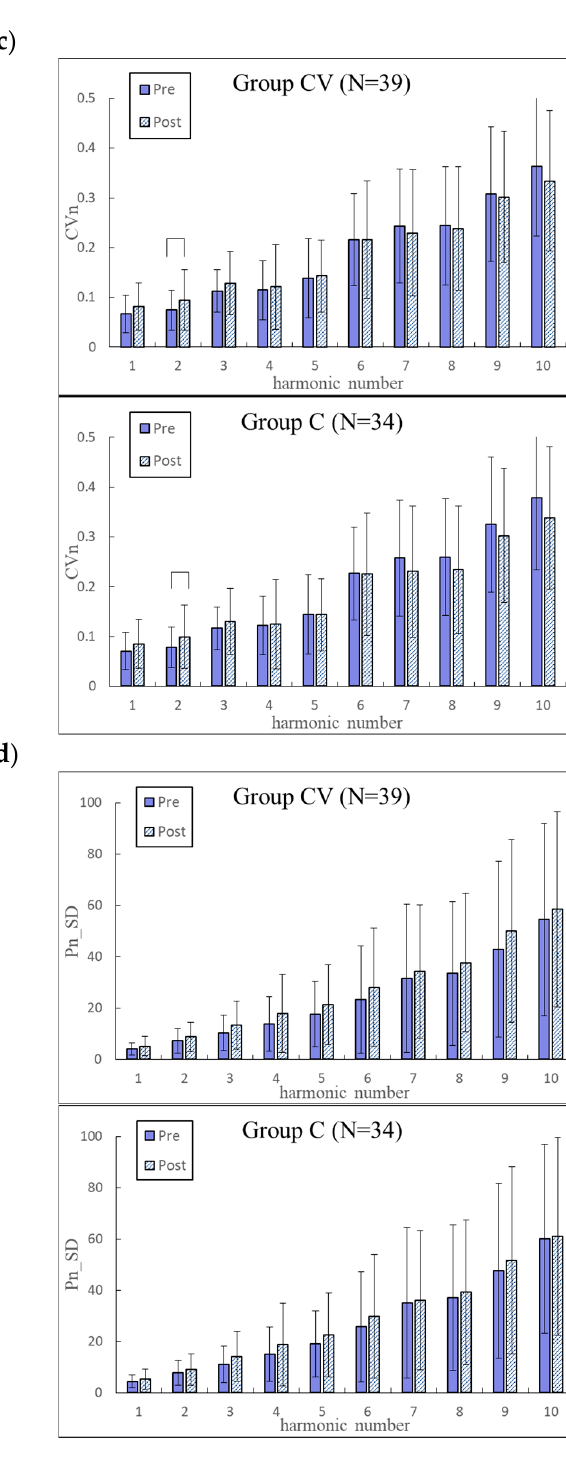
Figure 3. Comparisons of BPW harmonic indices between before and after vaccination in Groups N ( n = 28), CV ( n = 39), V ( n = 11), and C ( n = 34). Data are mean and standard deviation values. C 5 – C 10 values have been multiplied by 10 to make the differences clearer. “ ︹ ” indicates p < 0.05. ( a ) For C n , there was no significant change in Group C. In Groups N and CV, there were only significant dif- ferences in C 2 . There were more prominent changes in Group V, especially in higher frequency com-